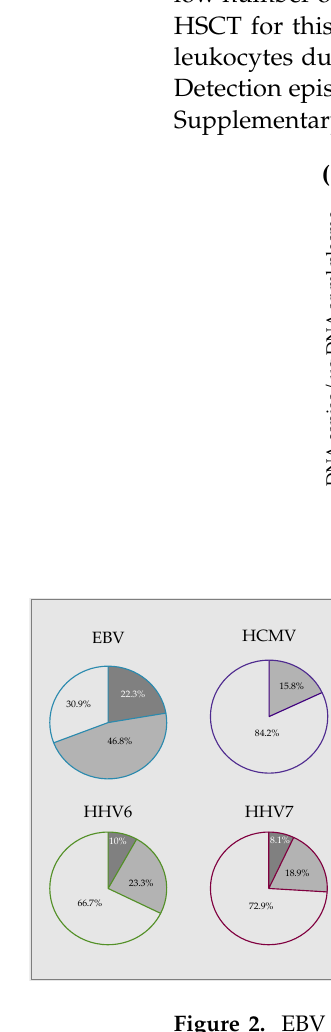
Figure 2. EBV DNA is found mainly in plasma, whereas HCMV, HHV6 and HHV7 DNA are predominantly in leukocytes. ( a ) Example of the detection episodes in plasma and leukocytes in a patient with allo-HSCT during one year of follow-up. ( b ) Frequencies of EBV, HCMV, HHV6 and HHV7 detection in leukocytes, plasma or leukocytes and plasma simultaneously. ( c ) Paired analyses of the viral load in leukocytes and plasma for each virus. The mean value is up to the bars. Paired Mann–Whitney test. **** = p < 0.0001, ns = non-significant.